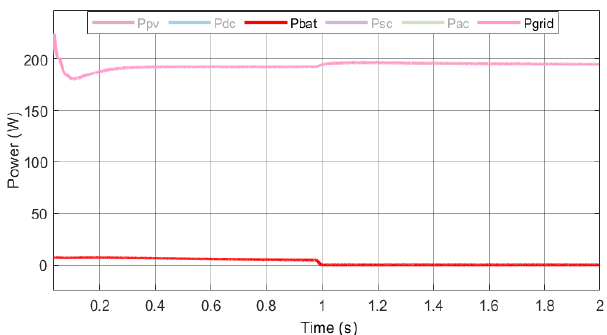
Figure 20. Grid and battery power in DPM.